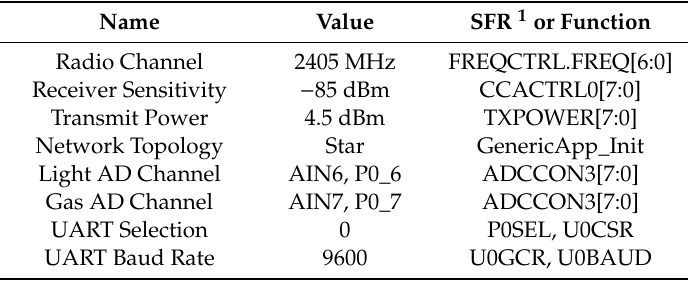
Table 4. Key settings for ZigBee